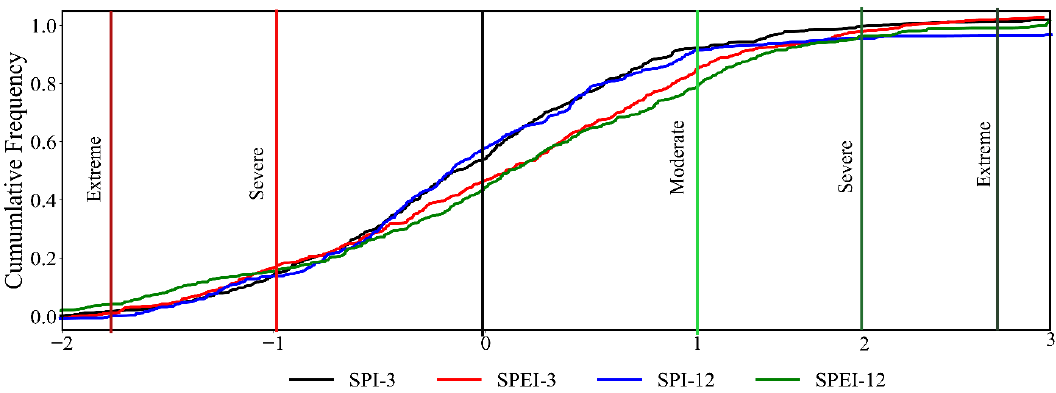
Figure 2. The empirical cumulative frequency of the monthly Standardized Precipitation Index (SPI) and the Standardized Precipitation–Evapotranspiration Index (SPEI) for the Kenya region. Vertical lines represent the dry spell (red) and wet spell (green) thresholds, classified in drought indices presented by Gozzo et al. [63].